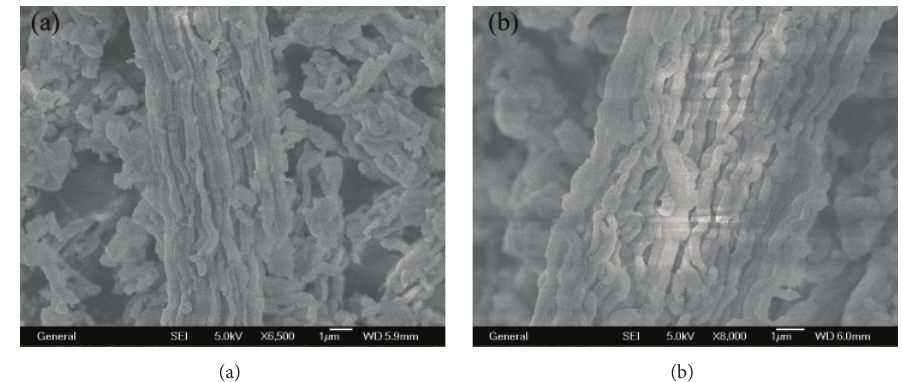
Figure 4: SEM image of (a) SBA-15 and (b) K 2 CO 3 -doped SBA-15.